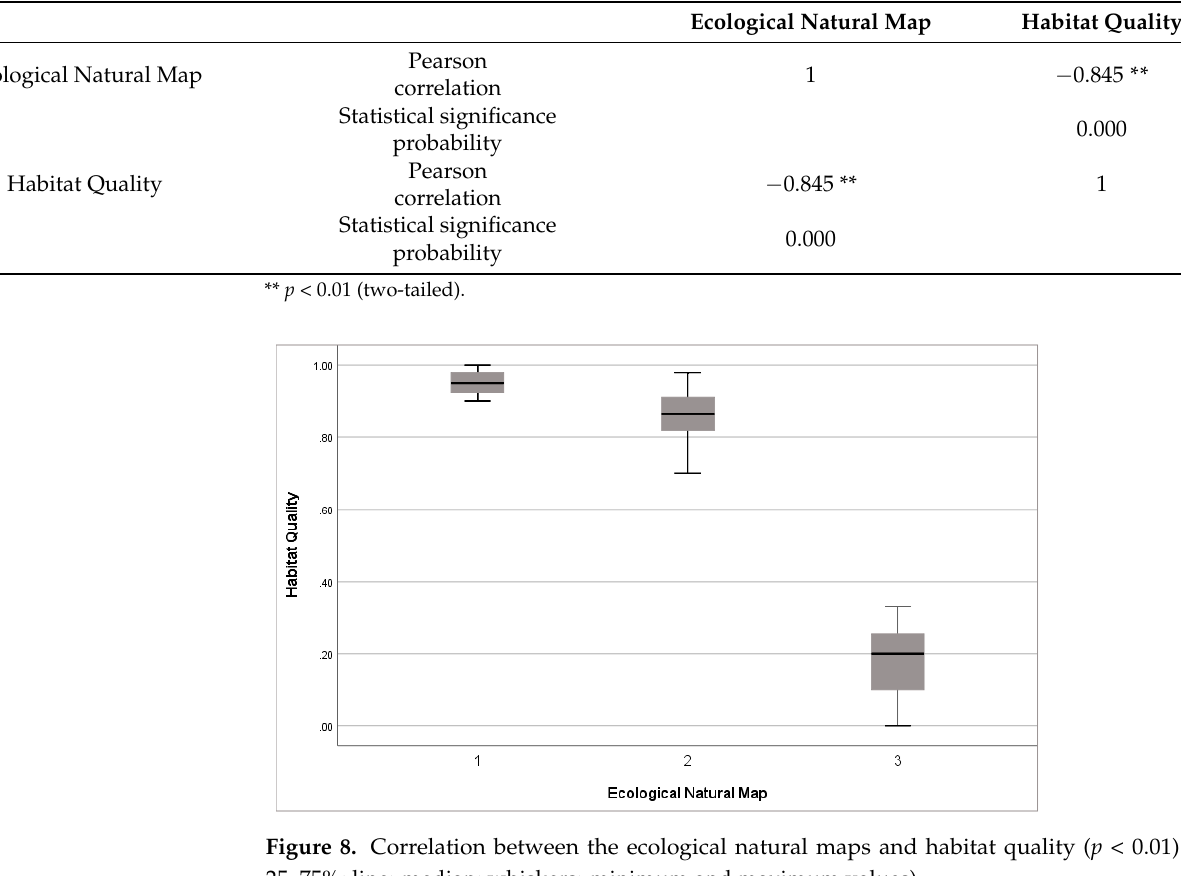
Figure 8. Correlation between the ecological natural maps and habitat quality ( p < 0.01). (Box: 25– 75%; line: median; whiskers: minimum and maximum values).